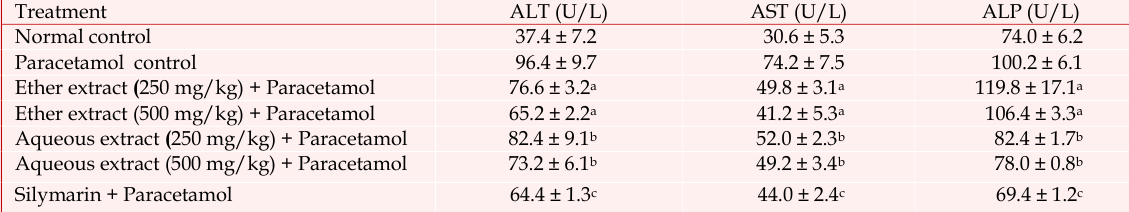
Effects of ether and aqueous extracts of Thymus linearis and silymarin on liver enzymes against paracetamol- treated hepatotoxic albino mice